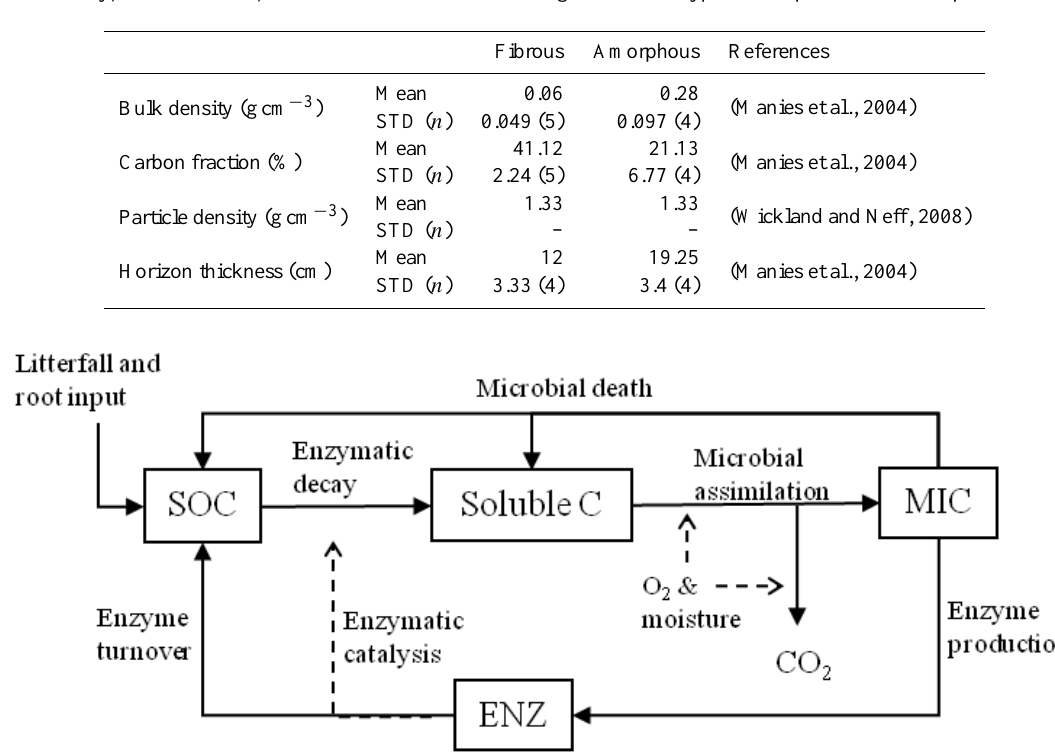
Table 1. Bulk density, carbon fraction, horizon thickness for different organic horizon types in soil profiles of black spruce stand in this study.